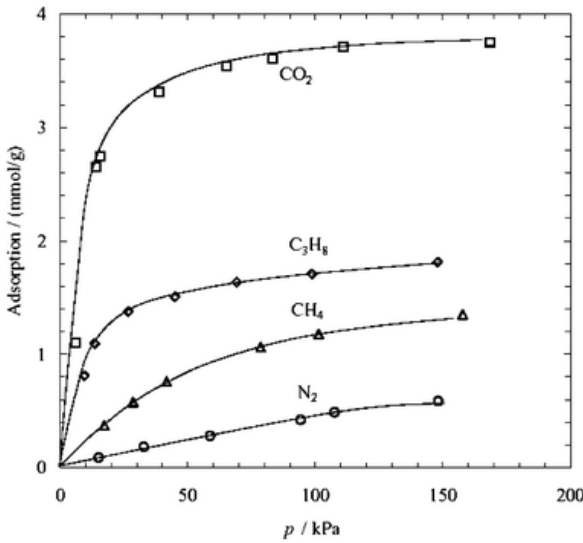
Figure 8. Adsorption isotherms of CO 2 , N 2 , CH 4 and C 3 H 8 measured at 25 °C on zeolite T powder [72].